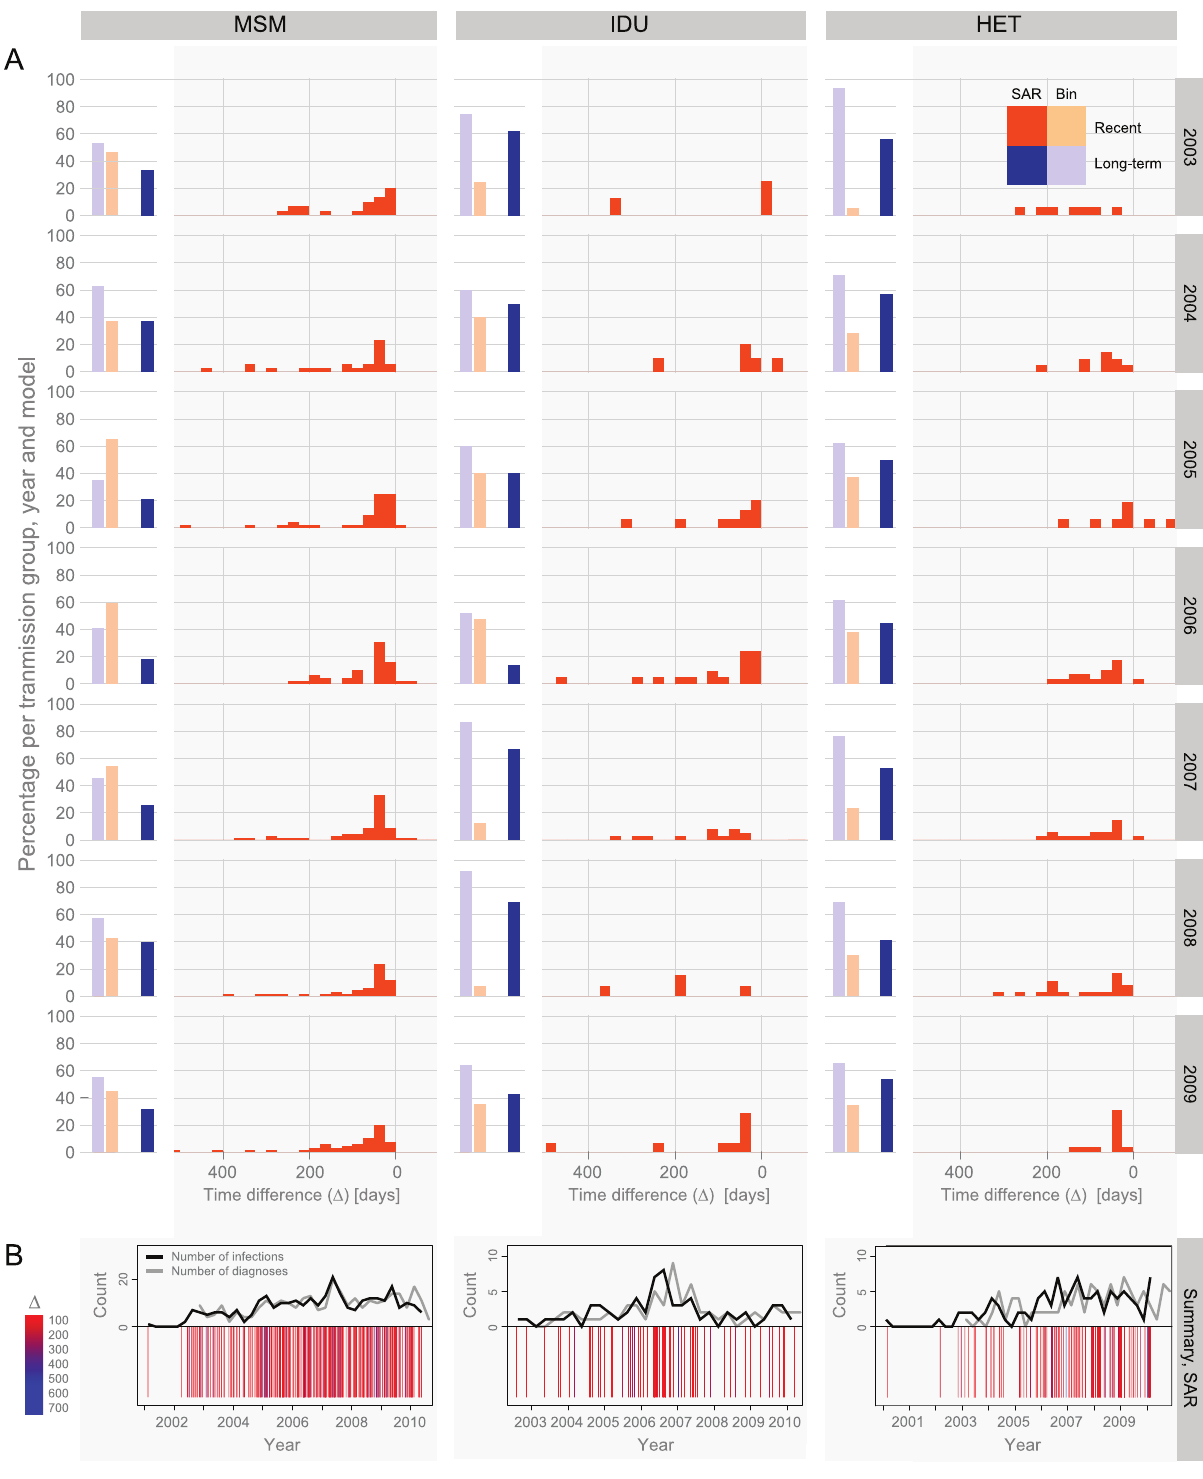
Figure 5. Lattice graph showing date of infection analysis of the Swedish data. ( A ) Time difference ( D ) distributions for the SAR model (dark shades) and Bin (binary) model (light shades) according to transmission group and year. Time differences either fall within (orange) or beyond (blue) the ‘‘recent’’ or quantifiable time since seroconversion, for Bin and SAR respectively. ( B ) Inference of dates of infection according to transmission group. Each bar in the lower part of each graph represents one inferred infection date, colored according to the time difference D (same colors as in Figure 4). The upper part of each graph summarizes the number of diagnoses (grey line) and infections (black line) for each quarterly year. For clarity, we have omitted the 95% CI on the bars and curves. See figures 2, 3, and S3 for confidence estimates.